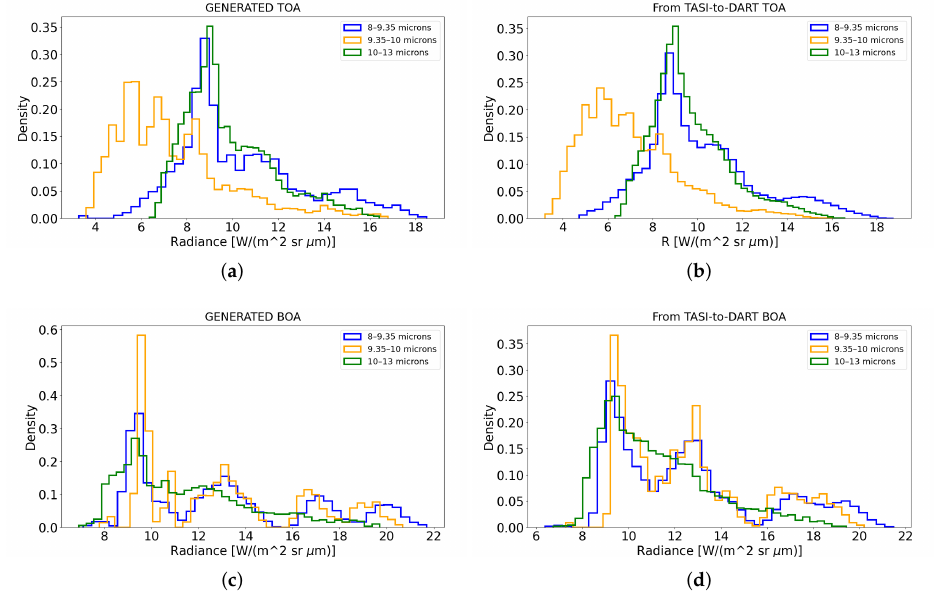
Figure 6. ( a ) TASI2DART-generated TOA radiance distribution. ( b ) TASI-to-DART TOA radiance distribution. ( c ) TASI2DART-generated BOA radiance distribution. ( d ) TASI-to-DART BOA radiance distribution.